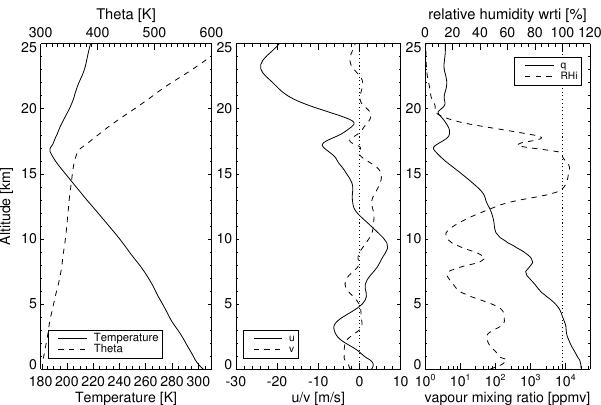
Figure 3. Profile of meteorological parameters prior to Hector de- velopment (04:30UTC). Profiles are averaged over domain 5 and show temperature and potential temperature in the left panel, the u and v wind components in the middle panel, and relative humidity with respect to ice and water vapour mixing ratio in the right